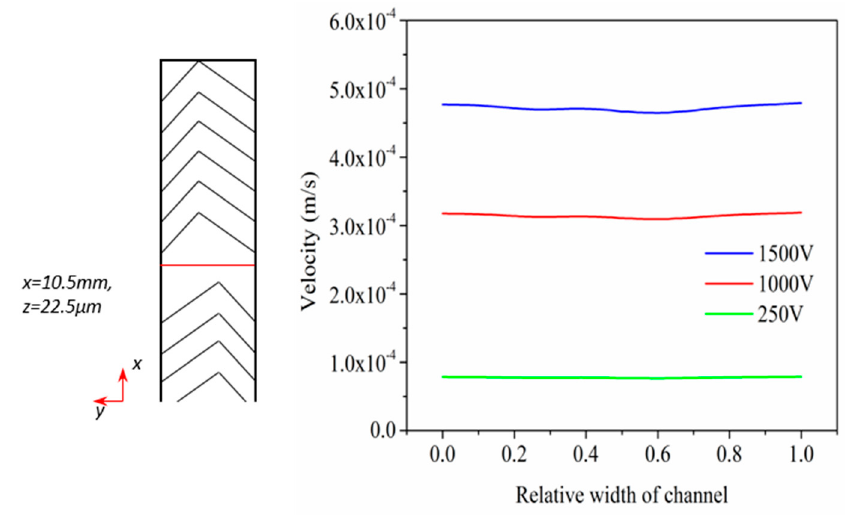
Figure 6. ( a ) Description of the middle position, ( b ) Velocity comparison at middle position of main channel in